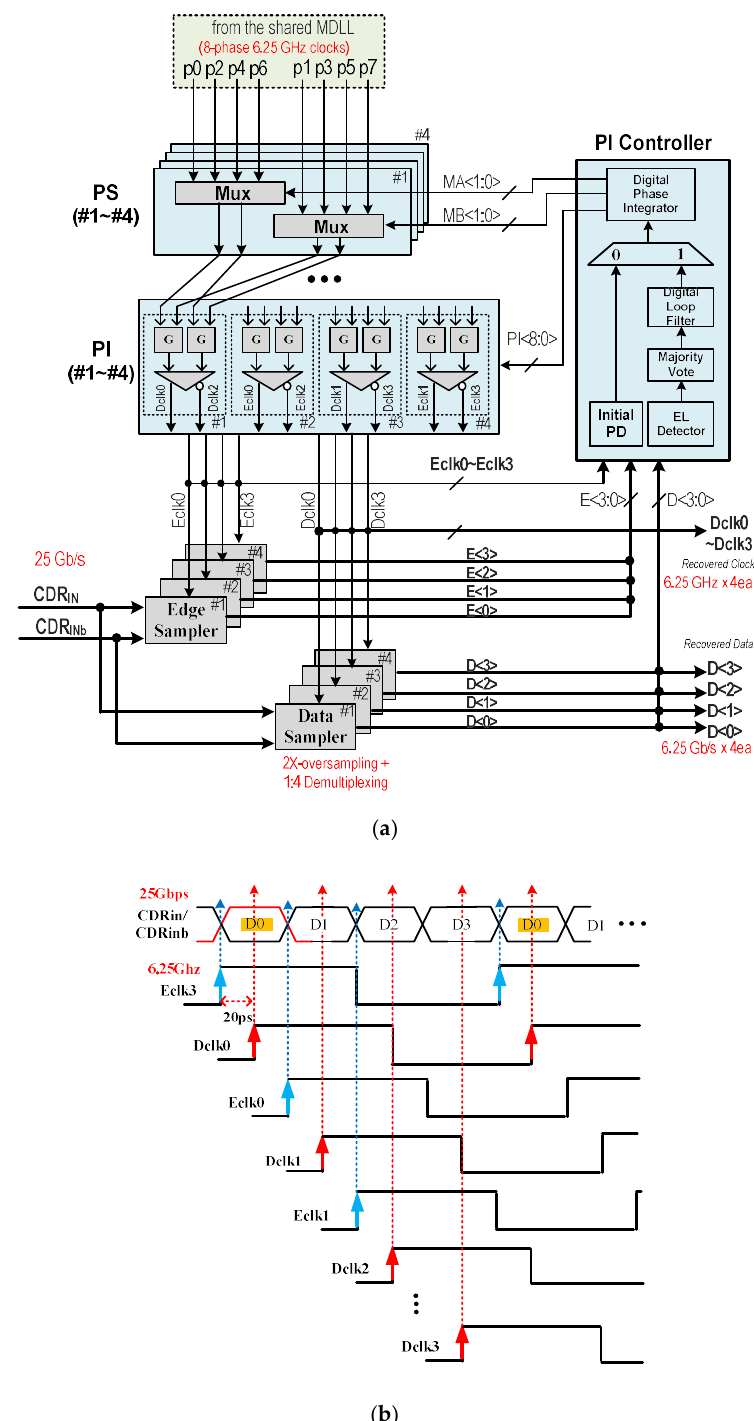
Figure 4. ( a ) Block diagram of the proposed all-digital PI-based quarter-rate CDR ( b ) and the CDR operation in locked